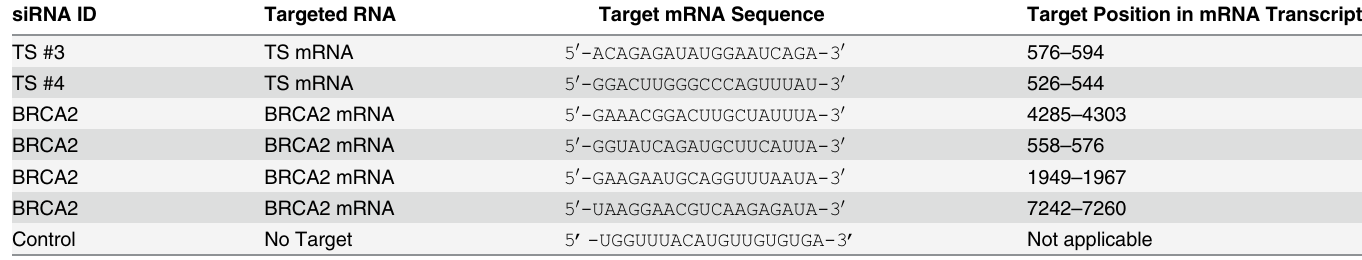
Table 1. 1. ON-Target Plus 1 TS and BRCA2 siRNA target mRNA sequences. siRNA